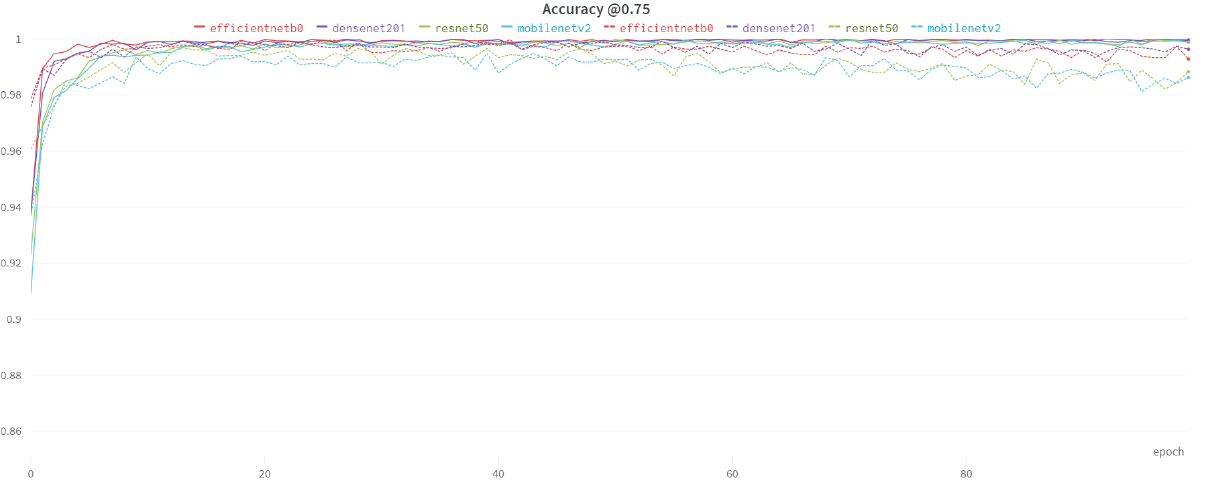
Figure 14. Comparison of the accuracy among ResNet50, DenseNet, MobileNetV2, and EfficientNet- B0 with a threshold score of